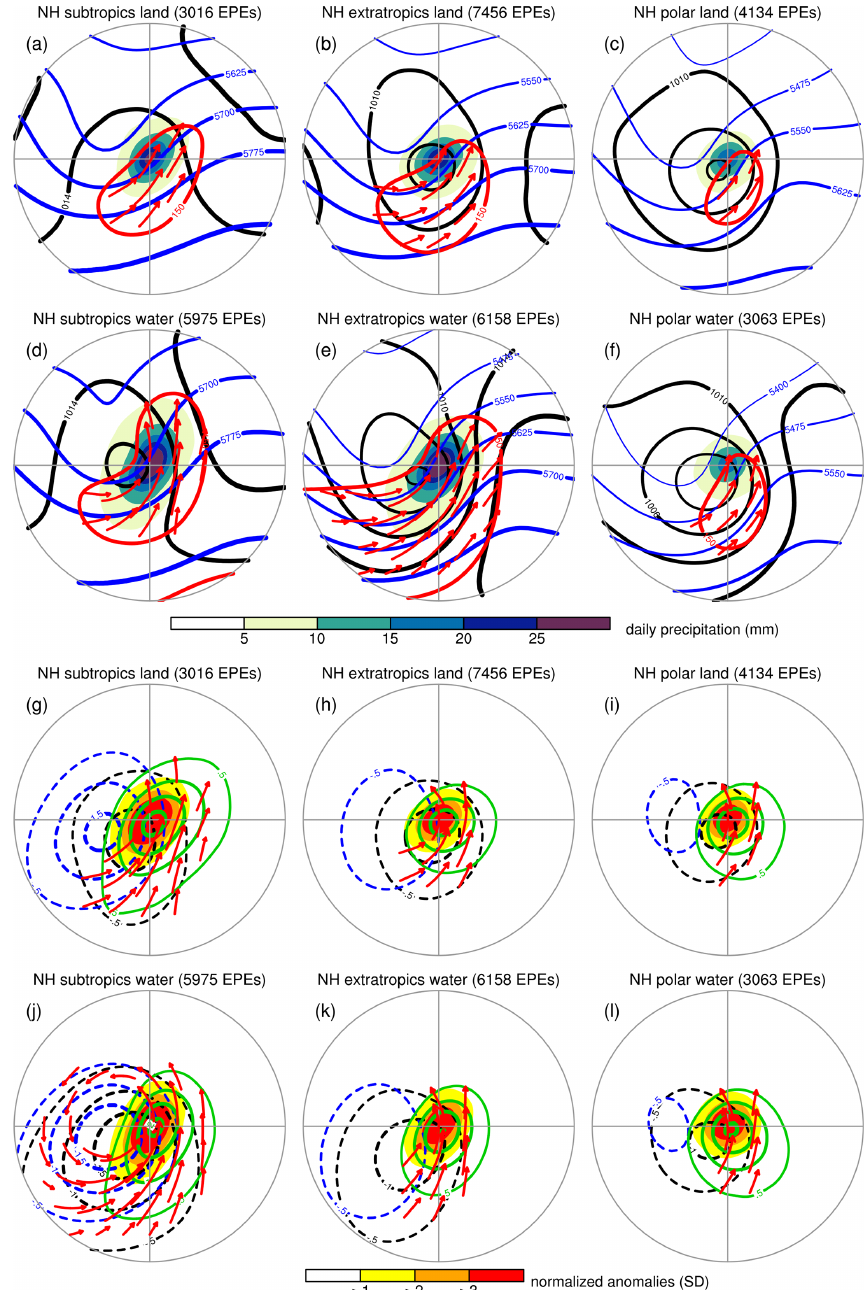
Figure 10. Composites of the tropospheric circulation for EPEs linked to combined Rossby wave breaking and intense moisture transport with (a–f) daily means and (g–l) normalized anomalies. The composites have a radius of 2000km and are centred on the mass-weighted centres of the EPEs for subtropical (20–40 ◦ N), extratropical (40–60 ◦ N), and polar (60–80 ◦ N) regions in the Northern Hemisphere over ( a, b, c and g, h, i ) land and ( d, e, f and j, k, l ) water during the period of 1979–2018. Shading in (a–f) shows daily precipitation (mm) and in (g–l) their normalized anomalies (SD). The contour lines in (a–f) show daily means of the 500hPa geopotential height (gpm, in blue), mean sea level pressure (hPa; in black), and IVT magnitude (150kgm − 1 s − 1 contour in red) with IVT vectors where the IVT magnitude exceeds 150kgm − 1 s − 1 . The contour lines in (g–l) show normalized anomalies, in colours as in (a–f) , in standard deviation (SD) for intervals of ± 0 . 5SD starting at ± 0 . 5SD, with only contours for negative values of 500hPa geopotential height and mean sea level pressure, and for positive values of TCW (in green). Also, in (g–l) , IVT vectors are constructed from their zonal and meridional components and only displayed where their vector length exceeds